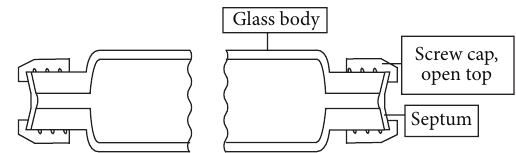
Figure 1: Sketch of the valveless gas sampling tube, sealed with septum